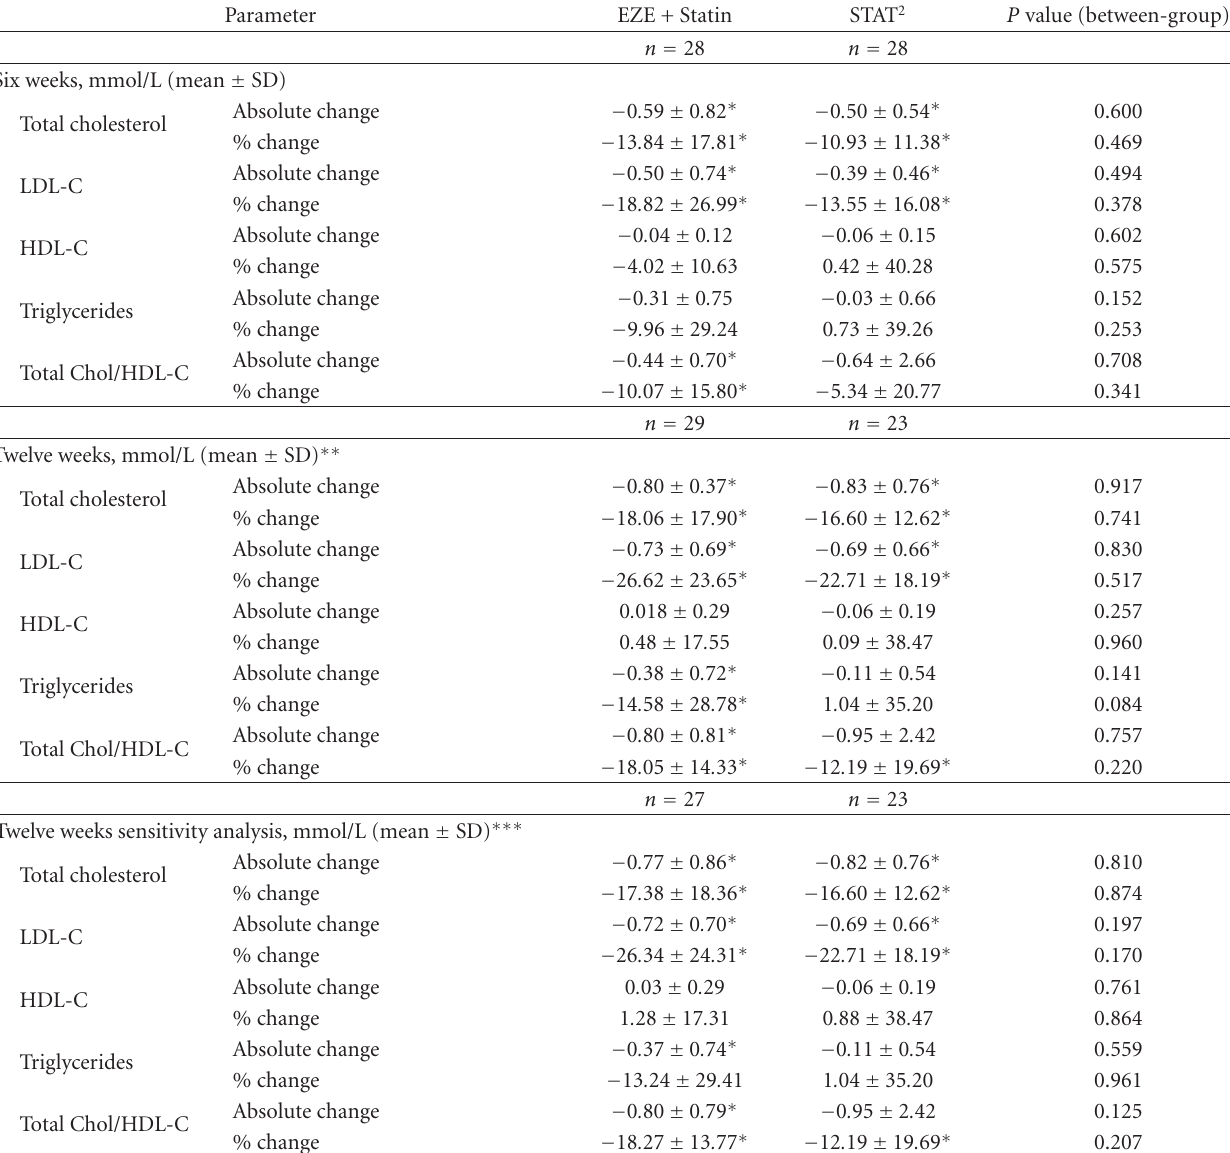
Table 3: Absolute and percent change in lipid parameters from baseline to 6 weeks and from baseline to 12 weeks, by treatment